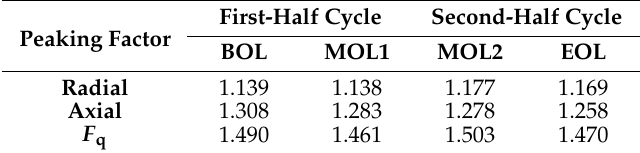
Table 4. Power peaking factors of KAIST MMR core.